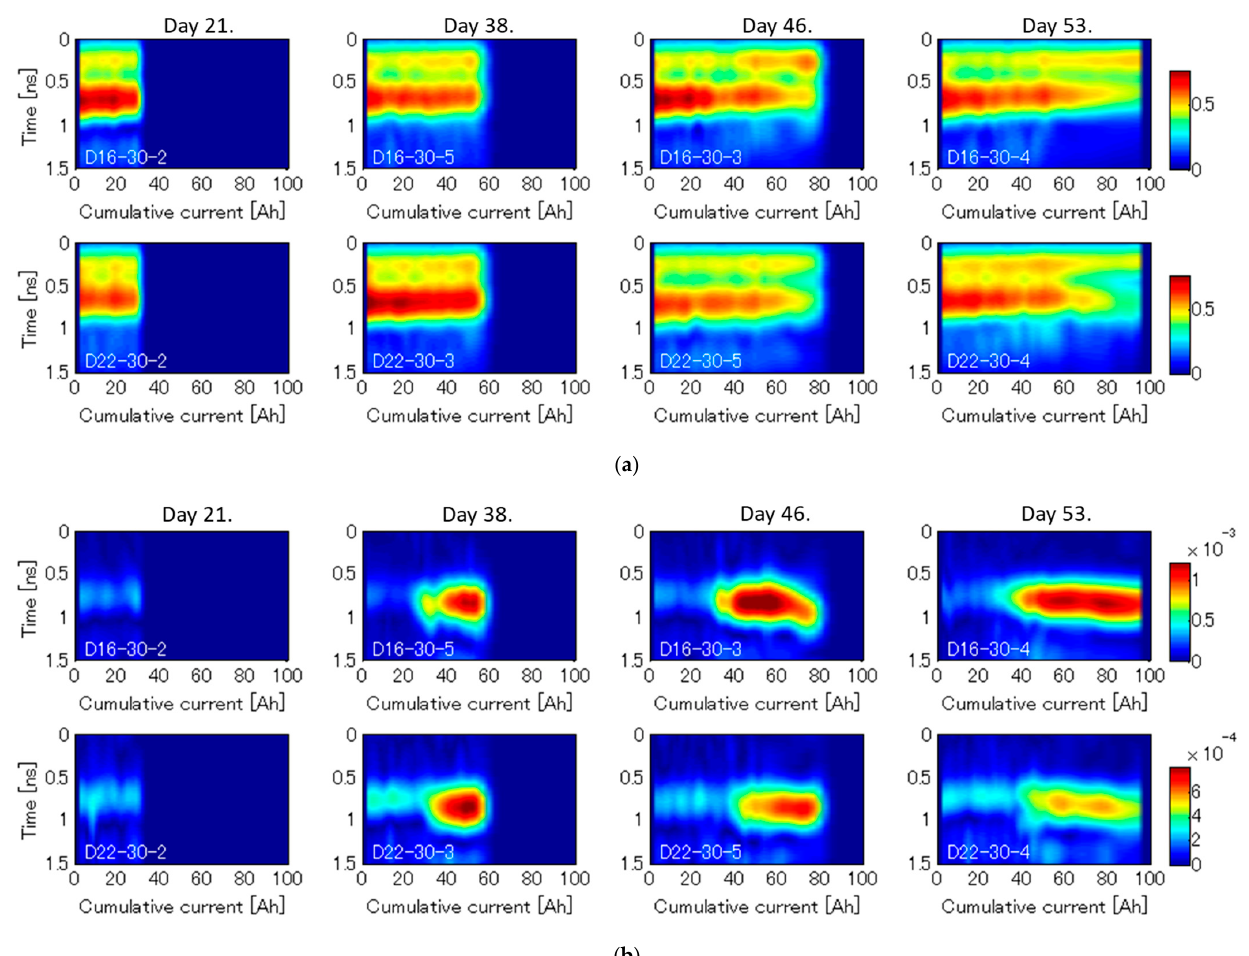
Figure 13. Monitoring results obtained by VDR while the electrolytic corrosion test in the case of D16 rebar for: ( a ) non-modulation components; ( b ) Doppler modulation components. The enveloped waveforms are aligned in the lateral direction as a function of the cumulative current with the amplitude representing in color scale. The amplitude of the Doppler component is multiplied by 1000.